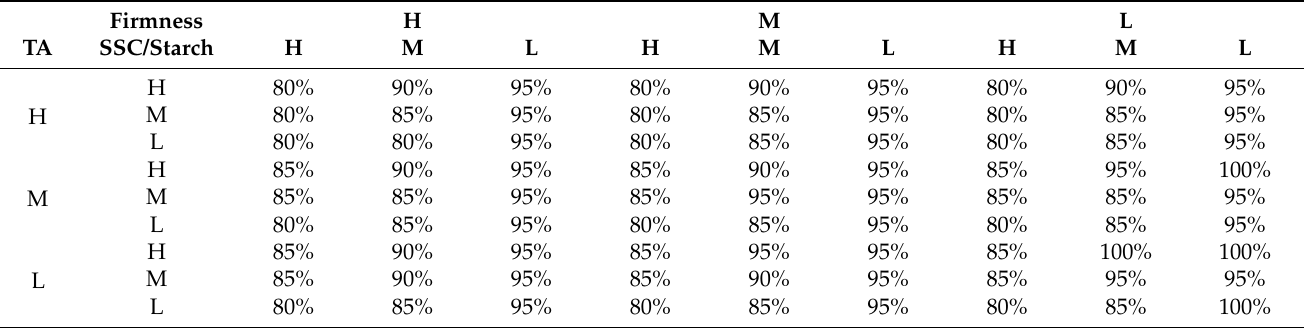
Table 9. If–then rules for converting fuzzy inputs to fuzzy outputs.